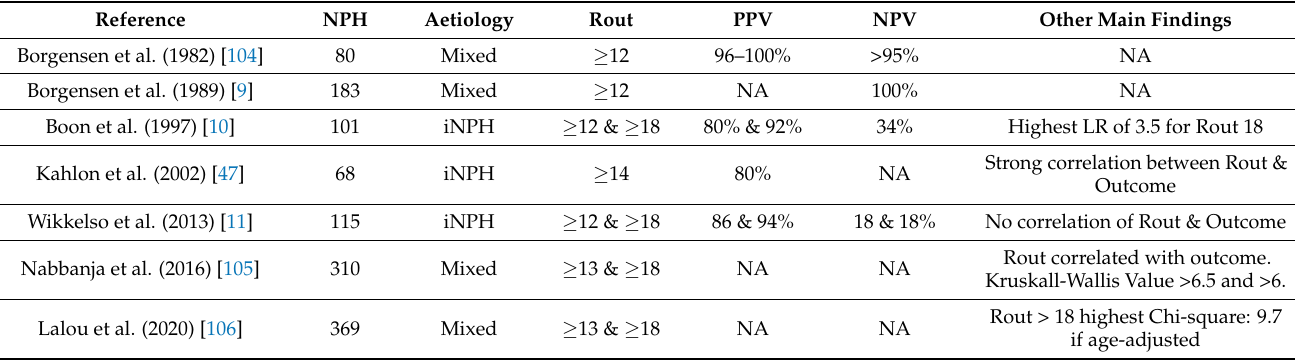
Table 1. Studies of Resistance to CSF outflow (Rout) and outcome after shunting in NPH: prediction of outcome after shunting. LR: Likelihood ratio, PPV: positive predictive value, NPV: negative predictive value. Mixed Aetiology refers to NPH of all causes.